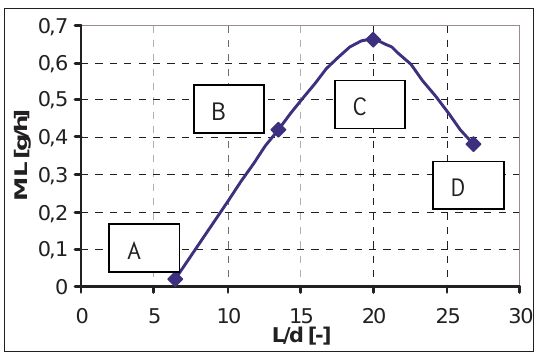
Fig. 10. Mass loss in dependence on L/d.